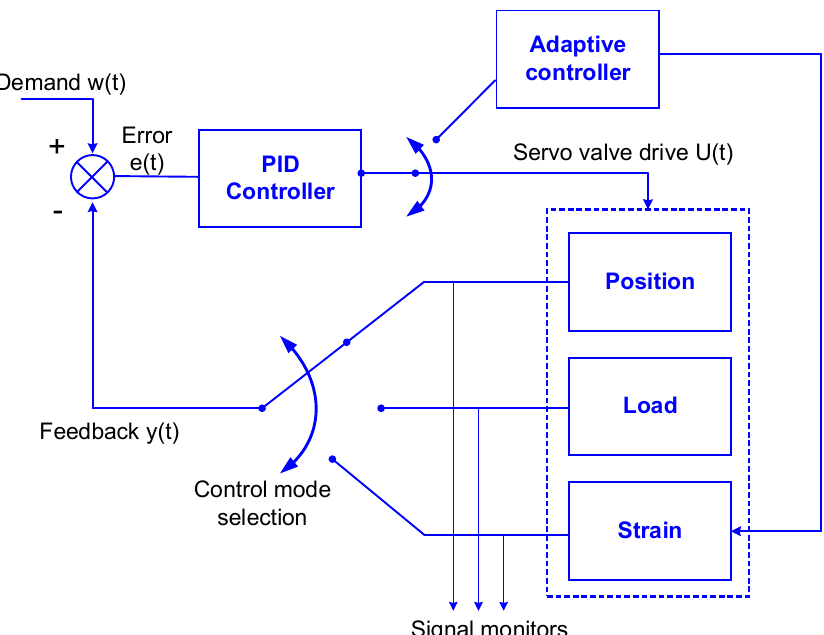
Figure 1. Control system of position, load, and strain channels under a strain control mode.